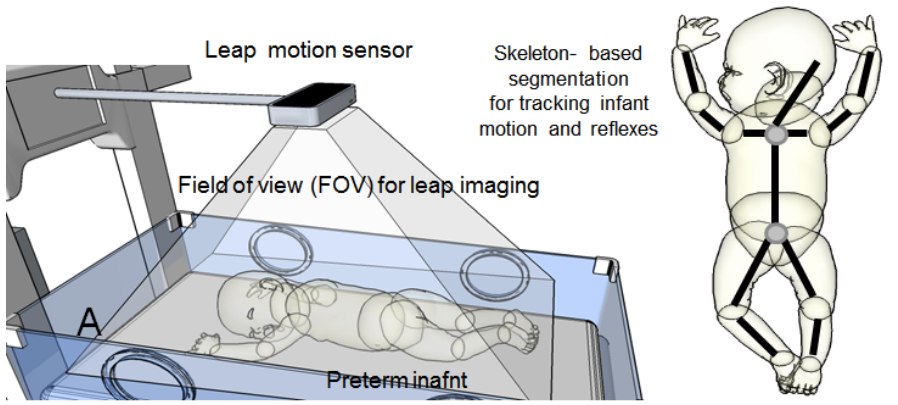
Figure 13. Experimental setup of a LeapMotion ® unit to monitor body movements of the neonate.